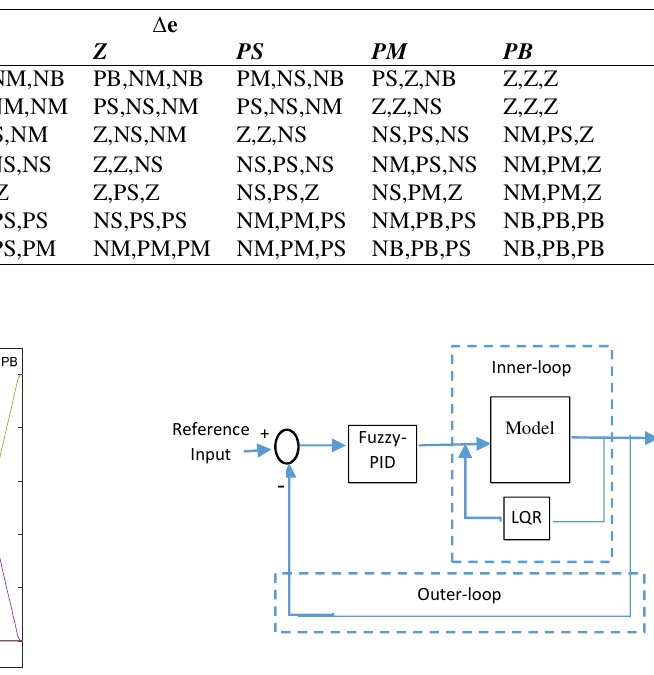
Fig. 6. Block diagram of the fuzzy-PID controller with